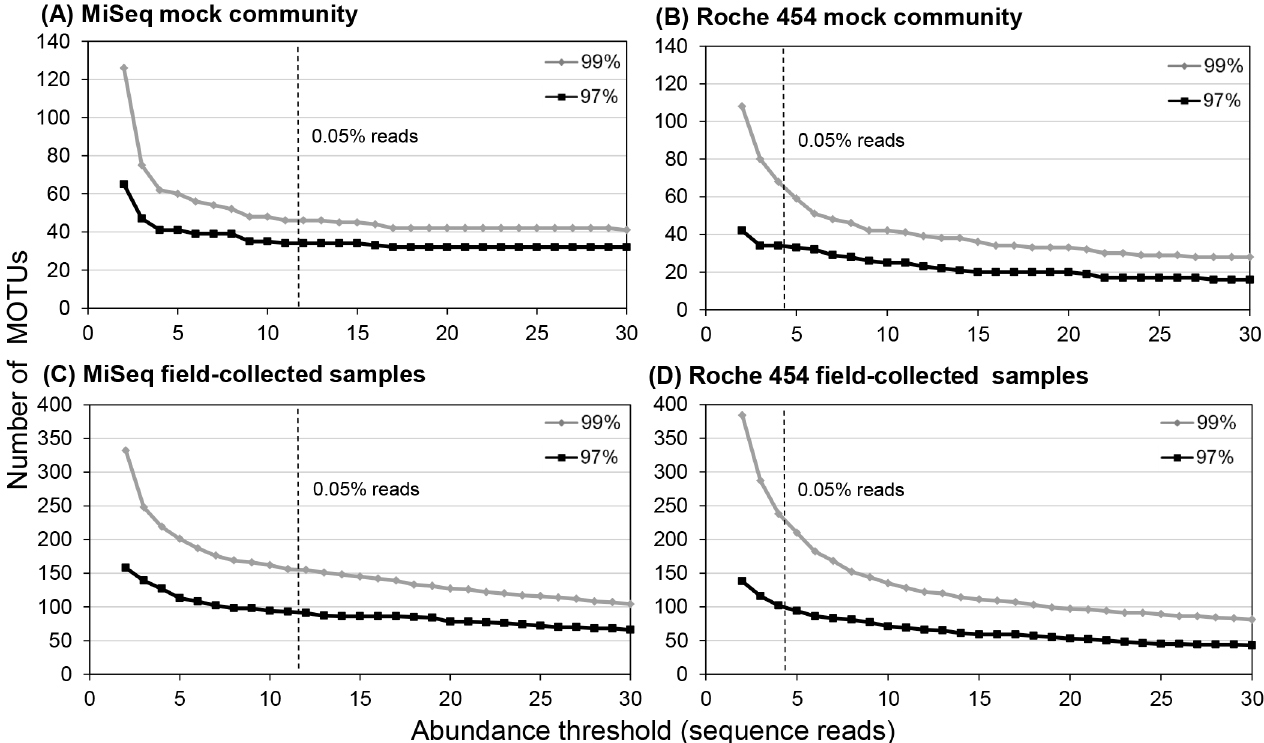
Fig 1. MOTU numbersat different minimum abundance thresholds of sequencereads: Comparisons of mock community analysisusing (A) Illumina MiSeq and (B) Roche 454, and analysesof field-collected samples using (C) Illumina MiSeq and (D) Roche 454. A 0.05% of total reads for a single sample is indicatedby dashedlines. Effects of the abundancethreshold on MOTU numberswere evaluatedboth at a 97 and 99% similarity thresholdfor MOTU clustering.